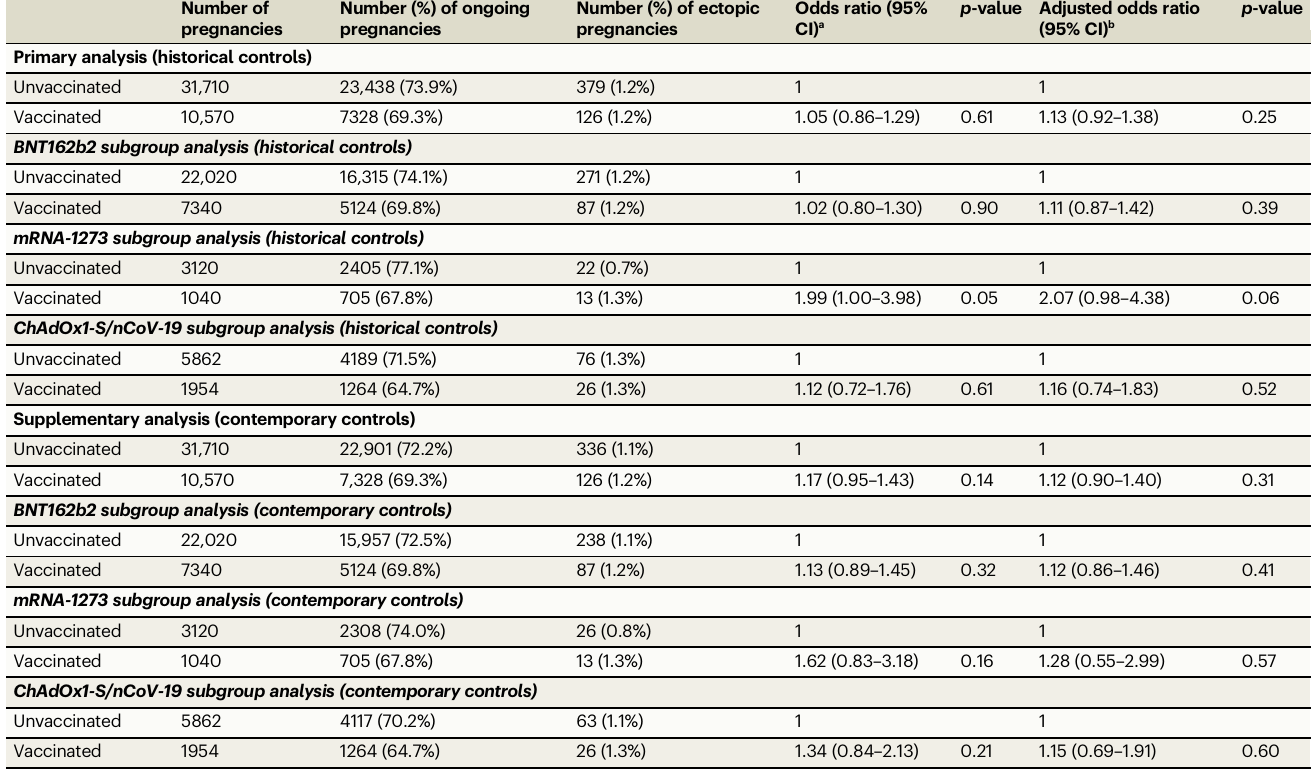
Table 3 | Odds ratios for the association between COVID-19 vaccination and ectopic pregnancy from multinomial logistic regression models Number of pregnancies